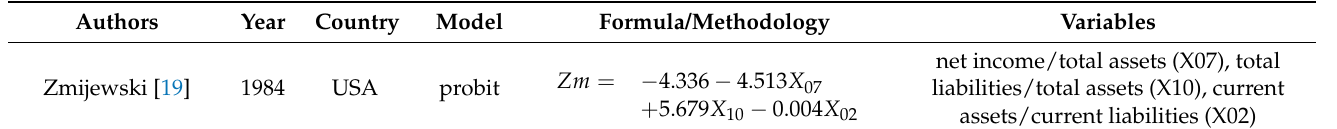
Table 13. The comparison of prediction models applied in V4 countries.